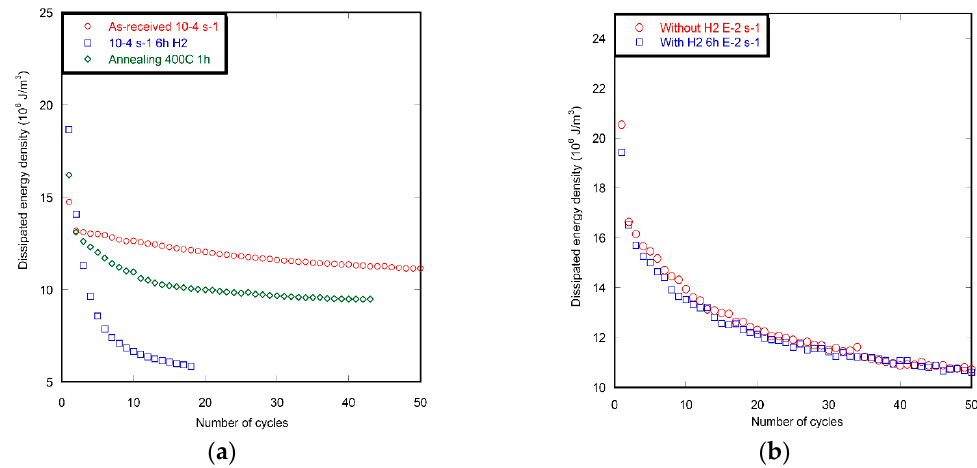
Figure 7. Evolution of dissipated energy density as a function of number of cycles of as-received and hydrogen charged specimen with imposed strain rate of ( a ) 10 − 4 s − 1 and ( b ) 10 − 2 s − 1 .